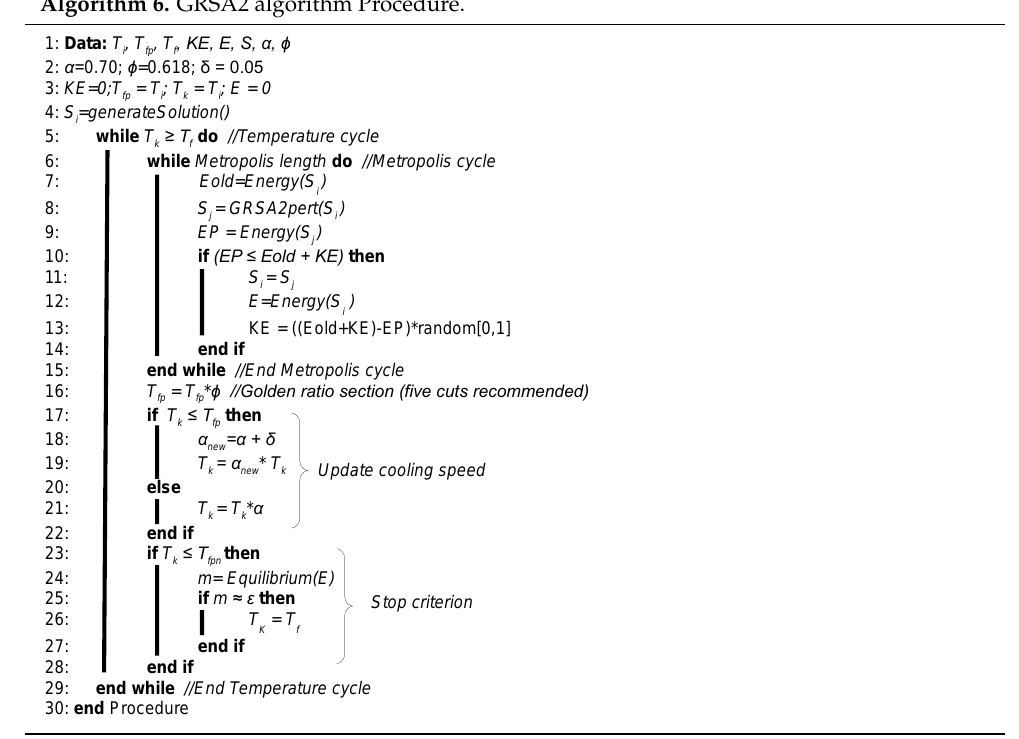
Algorithm 4.1 GRSA2pert Function